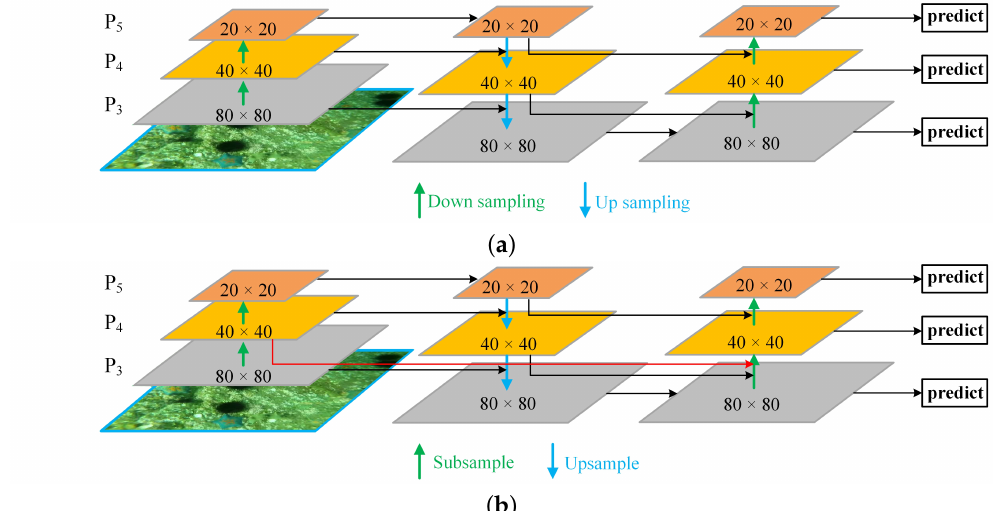
Figure 6. ( a ) The structure of PANet; ( b ) the structure of the improved